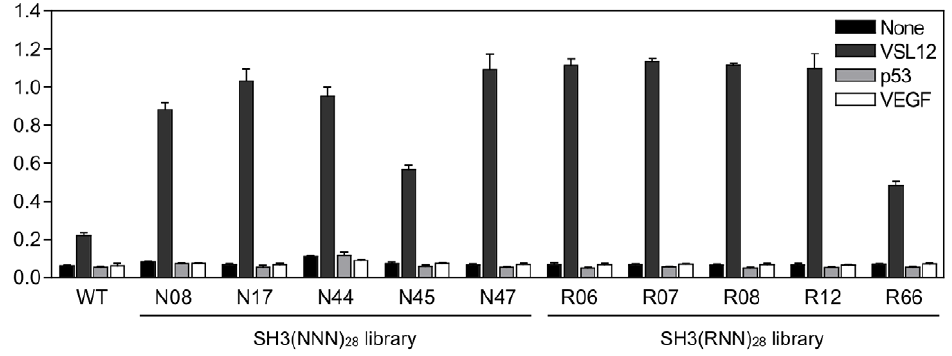
Figure 6. Binding specificity of selected proteins. Relative binding of selected proteins from the SH3(NNN) 28 and SH3(RNN) 28 libraries to several kinds of peptide (black, none; dark gray, VSL12; light gray, p53 371–380 ; white, VEGF 84–91 ) was analyzed by ELISA. WT, wild-type SH3 domain. Error bars indicate s.d. of four samples.